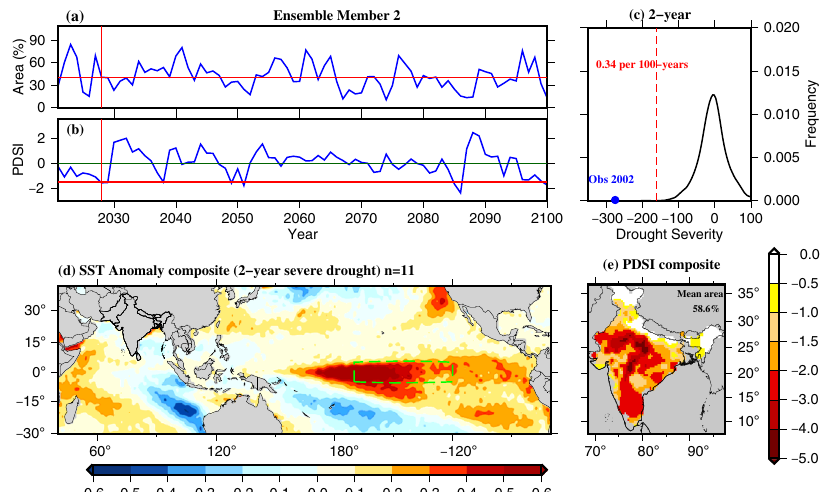
Fig. 7 Projected occurrence of megadroughts of two consecutive years in the future climate based on Community Earth System Model- Large Ensemble (CESM-LE). a Area under drought estimated using PDSI less than − 1.5 using the ensemble member two of CESM-LE, b PDSI estimated using the ensemble member two of the CESM-LE, c kernel density function of drought severity estimated using all the 40 ensemble members of CESM-LE. The vertical red line in c indicates the minimum drought severity of the megadroughts of 2 consecutive years, while the blue circle shows the drought severity of the 2002 megadrought. d SST anomaly composite for the June to August period for all the consecutive 2-year droughts that had PDSI less than − 1.5 and area under drought more than 40% (total 11 events in all the 40 ensemble members of 2021 – 2100 period each), and e composite of PDSI for all the megadroughts that occurred in all the 40 ensemble members of CESM-LE.